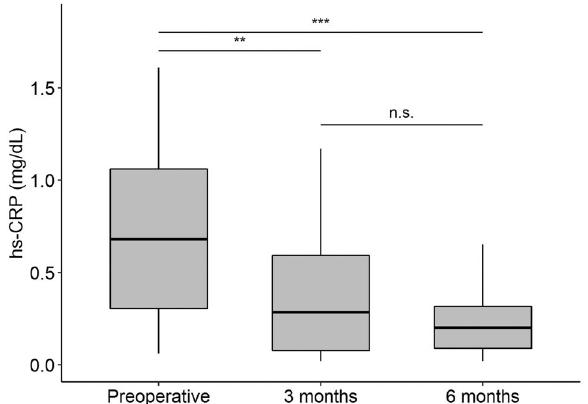
Figure 1. Changes in the levels of hs-CRP before and after bariatric surgery. n = 32; hs-CRP: high sensitivity C-reactive protein; ** p -value < 0.01, *** p -value < 0.001, n.s.: non-significant; Friedman test with Nemenyi post-hoc pairwise comparison test. This figure was made with the help of Tidyverse and Hmisc packages in R software.